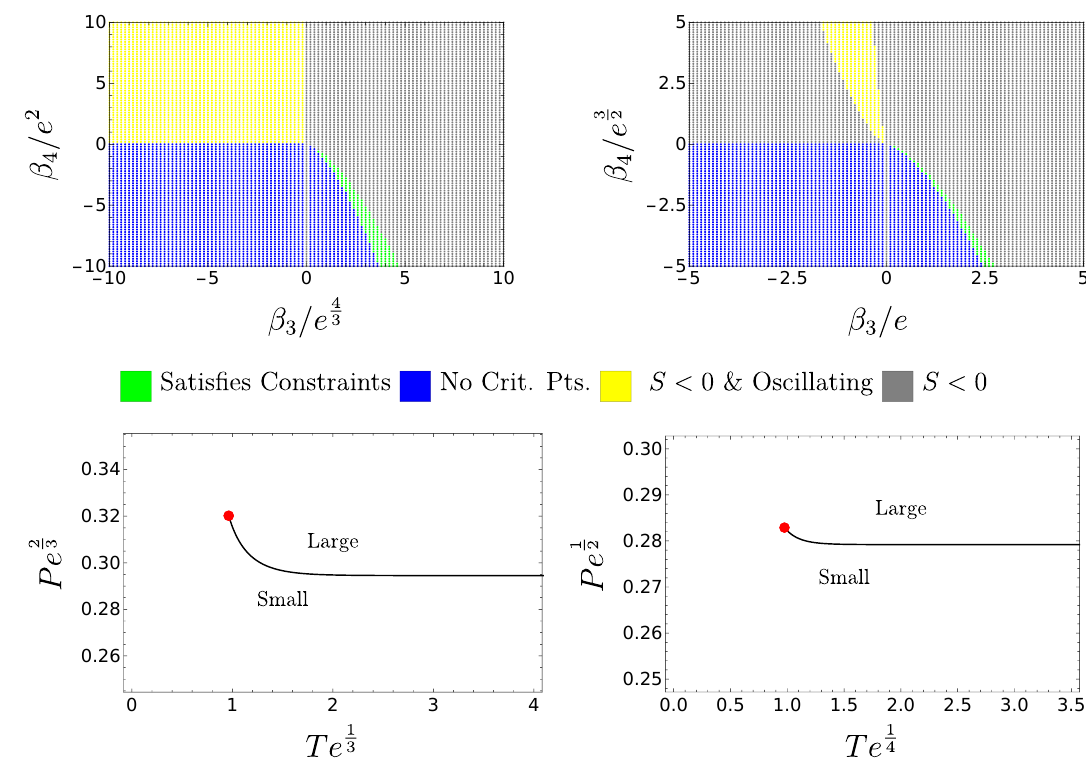
Figure 5 . Physicality constraints and phase diagrams in higher dimensions . Top left : the con- straints for six dimensions. Top right : the constraints for seven dimensions. Bottom left : the phase diagram for six dimensions. The red dot represents the critical point, while the black line repre- sents the coexistence curve for a (cid:12)rst order phase transition. This plot has been constructed for the particular choice of (cid:12) 3 = 1 ; (cid:12) 4 = (cid:0) 1 in units of the electric charge parameter, e . Bottom right : the phase diagram for seven dimensions. The red dot represents the critical point, while the black line represents the coexistence curve for a (cid:12)rst order phase transition. This plot has been constructed for the particular choice of (cid:12) 3 = 1 ; (cid:12) 4 = (cid:0) 5 = 4 in units of the electric charge parameter, e